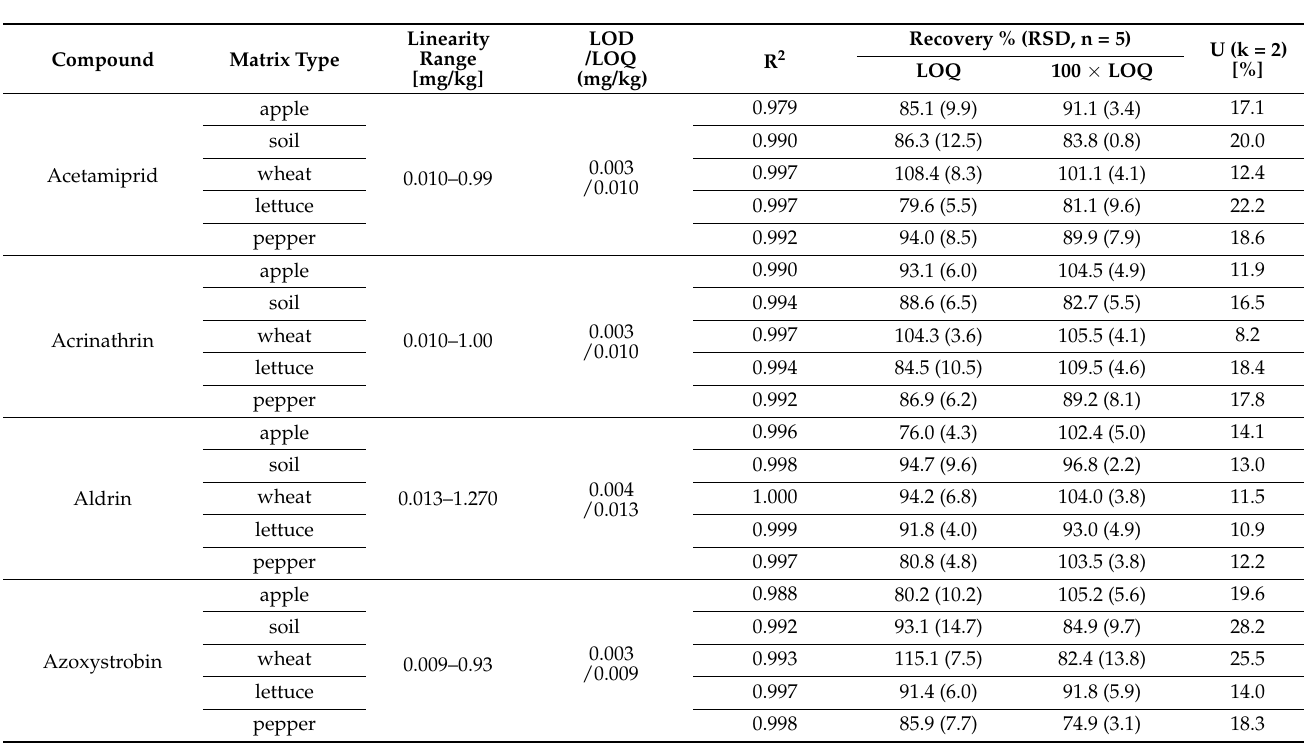
Table 3. Validation parameters for pesticide residue determinations (linearity range, calibration curve and coefficient of determination, recovery, standard deviation from recoveries (RSD), measurement uncertainty